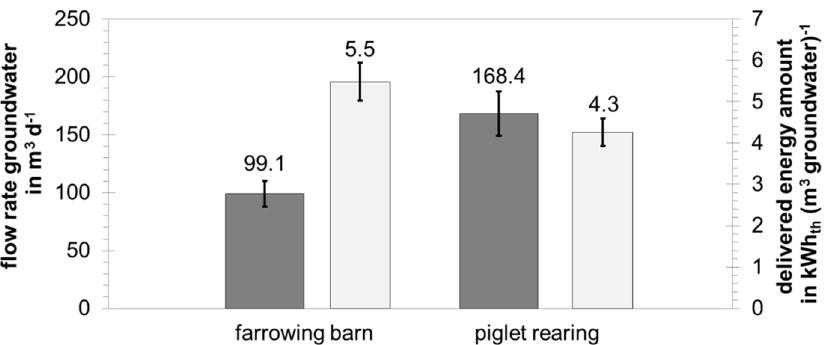
Figure 7. Daily groundwater flow rate (dark column) through the heat pumps and the achieved thermal energy per m 3 groundwater (light column). The equivalent standard deviations are also presented.